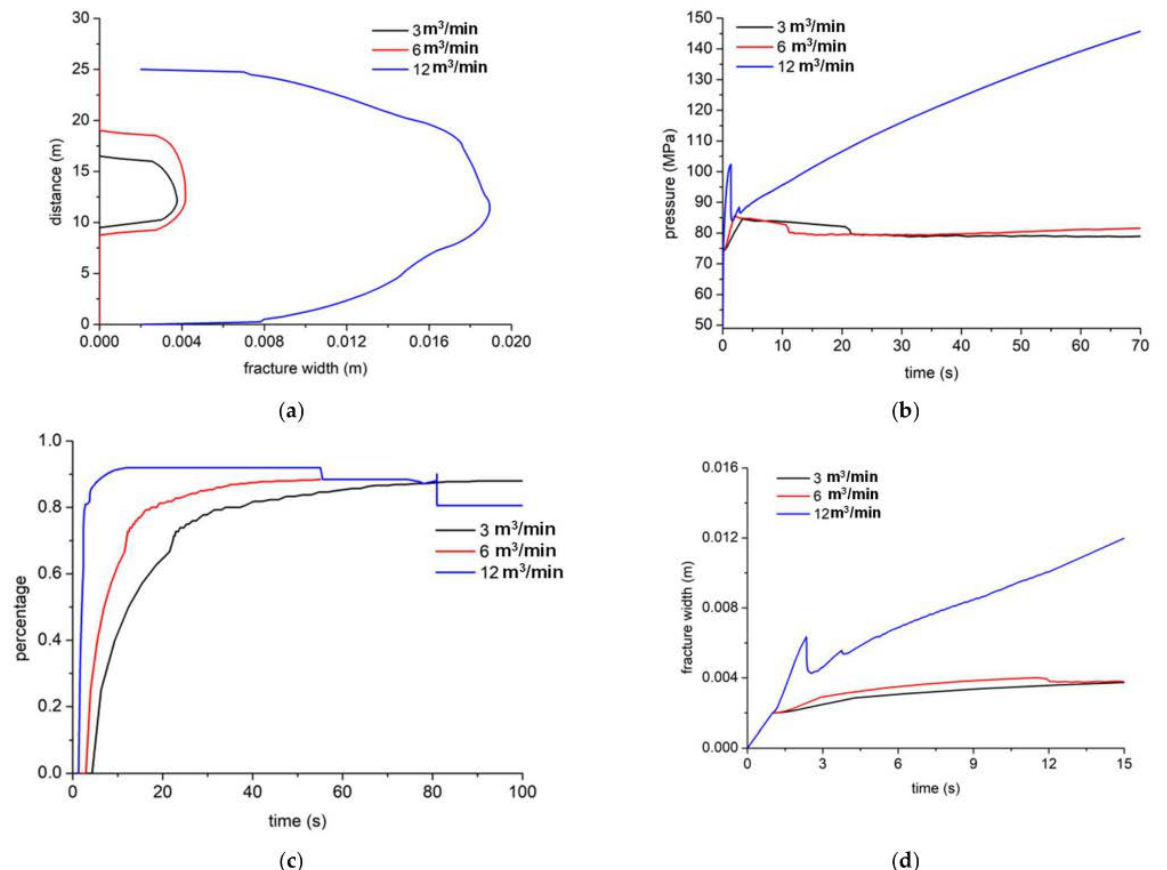
Figure 19. Fracture parameters under injection rate: ( a ) HF width; ( b ) pressure; ( c ) ratio of tensile failure; and ( d ) maximum HF